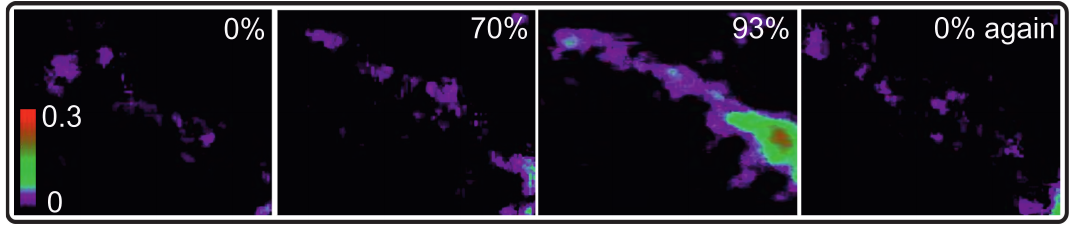
Fig. 9. Series of chemical maps showing the water uptake in aged wood soot particles, the images were measured at 543eV. The images were recorded at the same position at different RH. The color bar represents the scale of the OD in the images.